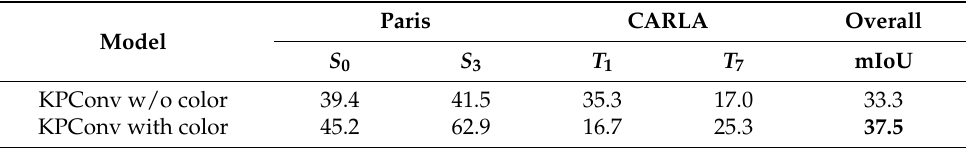
Table 3. Results in semantic segmentation task using KPConv [30] architecture on our PC3D dataset with and without RGB colors on LiDAR points. Results are mIoU in %. For S 0 and S 3 , training set is S 1 , S 2 . For T 1 and T 7 , training set is T 2 , T 3 , T 4 and T 5 . Overall mIoU is the mean IoU on the whole test sets (real and